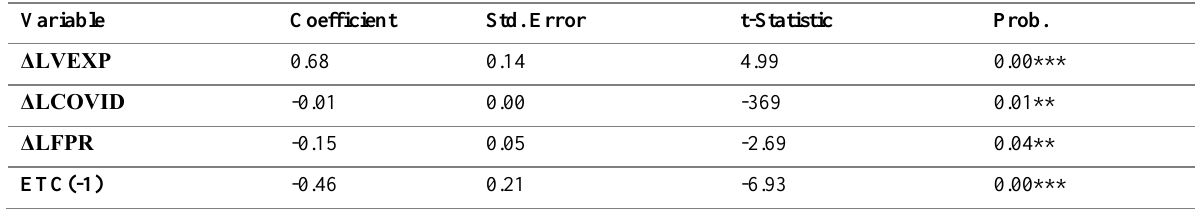
Table 7: Etc and Short-Run Results